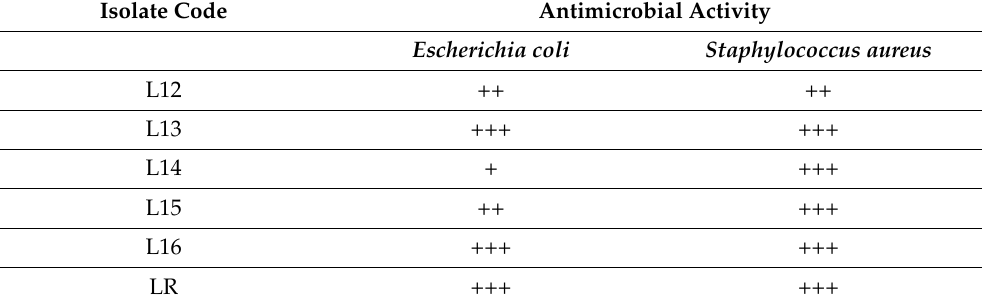
Table 3. Cont. Isolate Code Antimicrobial